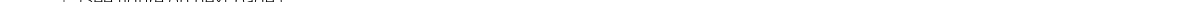
figure on next Fig. 4 LncRNA RP11-241J12.3 accelerated HCC growth in vivo . a Images of tumors that developed in nude mice. b Tumor growth curves of SMMC-7721 cells transduced with Lv-241J12.3 and Lv-NC in nude mice. Images ( c ) and weights ( d ) of tumor 5 weeks after cell injection. n mices per group. The tumors on both sides subsided in one mouse. e Representative images of H&E and IHC staining for tumor tissues (400 f Quantification of IHC staining showing that Ki67 expression was increased in the Lv-241J12.3 group compared to control group. Data were obtained from eight randomly selected fields in four representative slices from each group. g Representative images of Western blotting. h Quantitative analysis of western blotting. The Ki-67 protein expression in Lv-RP11-241J12.3-derived tumors was significantly higher than that in Lv-control-derived tumors ( n =